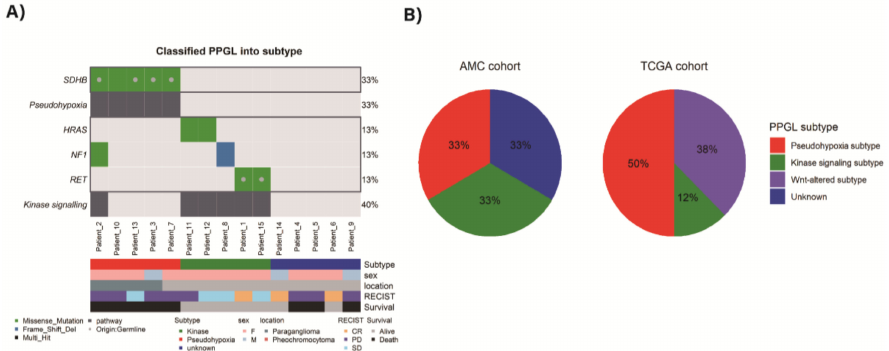
Figure 2. ( A ) Classified mutation subtypes of AMC PPGLs, ( B ) proportion of mutation subtypes in both AMC and TCGA